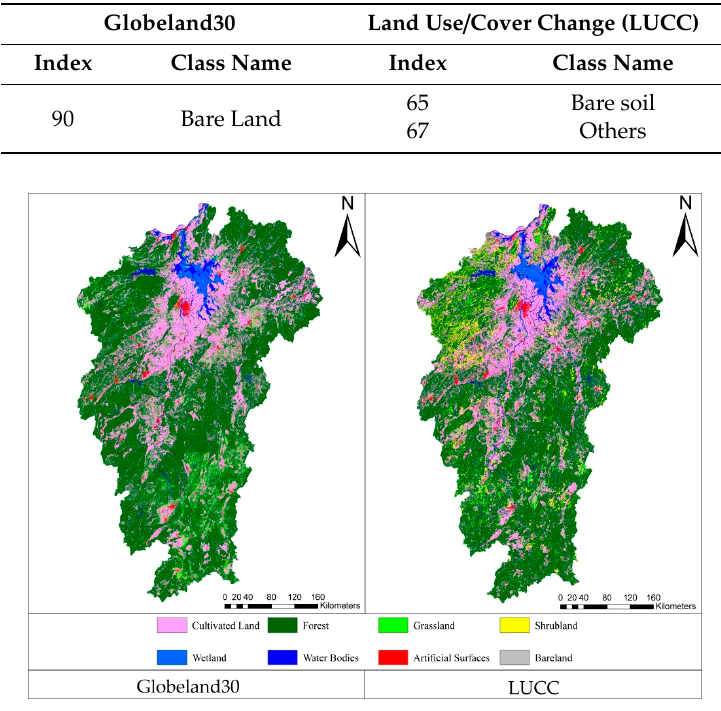
Figure 2. Globeland30 dataset and the reclassified land cover from land use/cover change (LUCC).